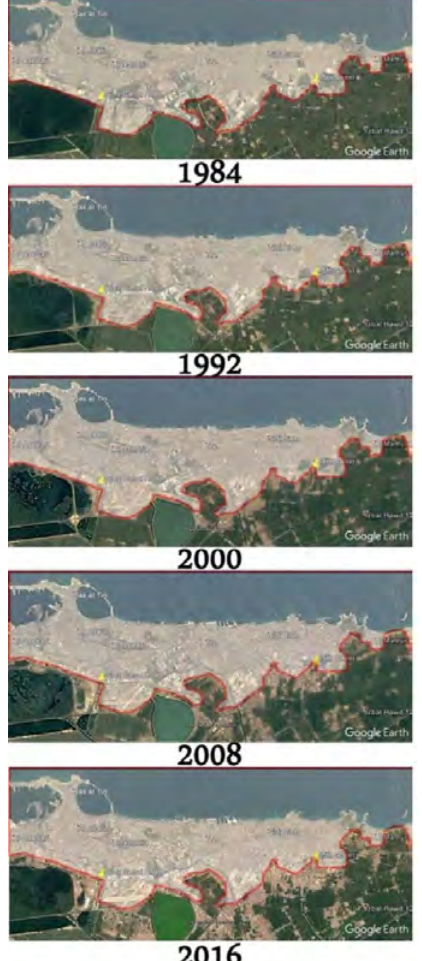
Figure 1. The city growth over the last four decades (Google Earth,